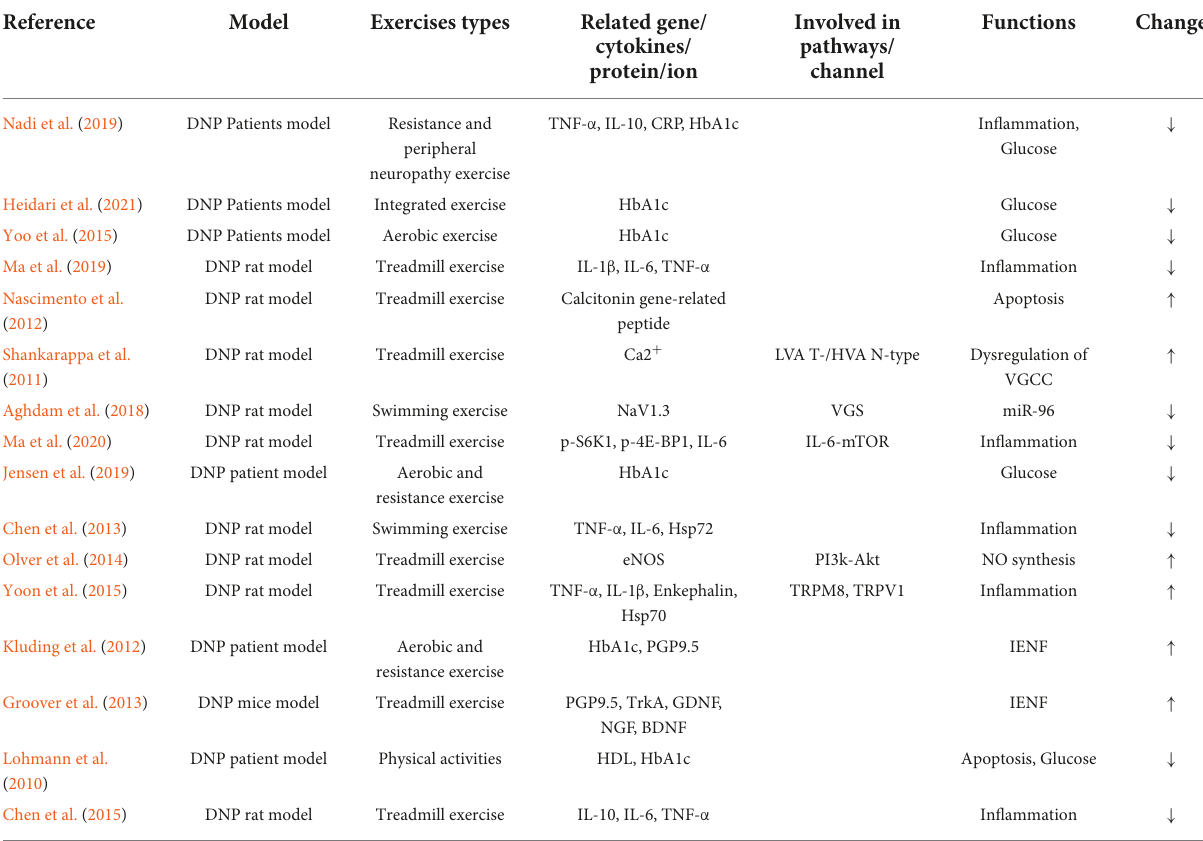
TABLE 1 The possible pathological mechanism of exercise in the treatment of